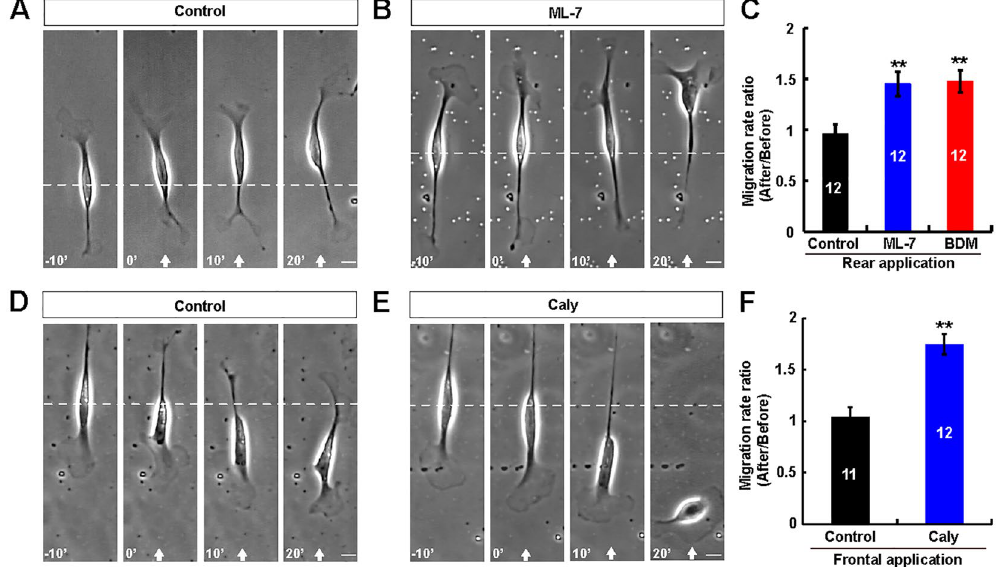
Figure 6. Increasing the front-to-rear difference of myosin II activity accelerated the soma translocation of Schwann cell-like OECs. ( A–B ) Images of migrating Schwann cell-like OECs before and after the rear application of a gradient of DMSO ( A ), or ML-7 ( B ). ( C ) Summary of migration rate ratios (after/before) of soma under the rear application of DMSO, or ML-7 or BDM. ( D–E ) Images of migrating Schwann cell- like OECs before and after the frontal application of a gradient of DMSO ( D ), or Caly ( E ). ( F ) Summary of migration rate ratios (after/before) of soma under the frontal application of DMSO or Caly. White arrowheads indicated the direction of the micropipette. The micropipette was loaded with 5 mM ML-7, or 200 mM BDM, or 25 μ M Caly. Time, min; scale bars, 20 μ m. Data were mean ± SD. ** P < 0.01 , compared with control, Student’s t